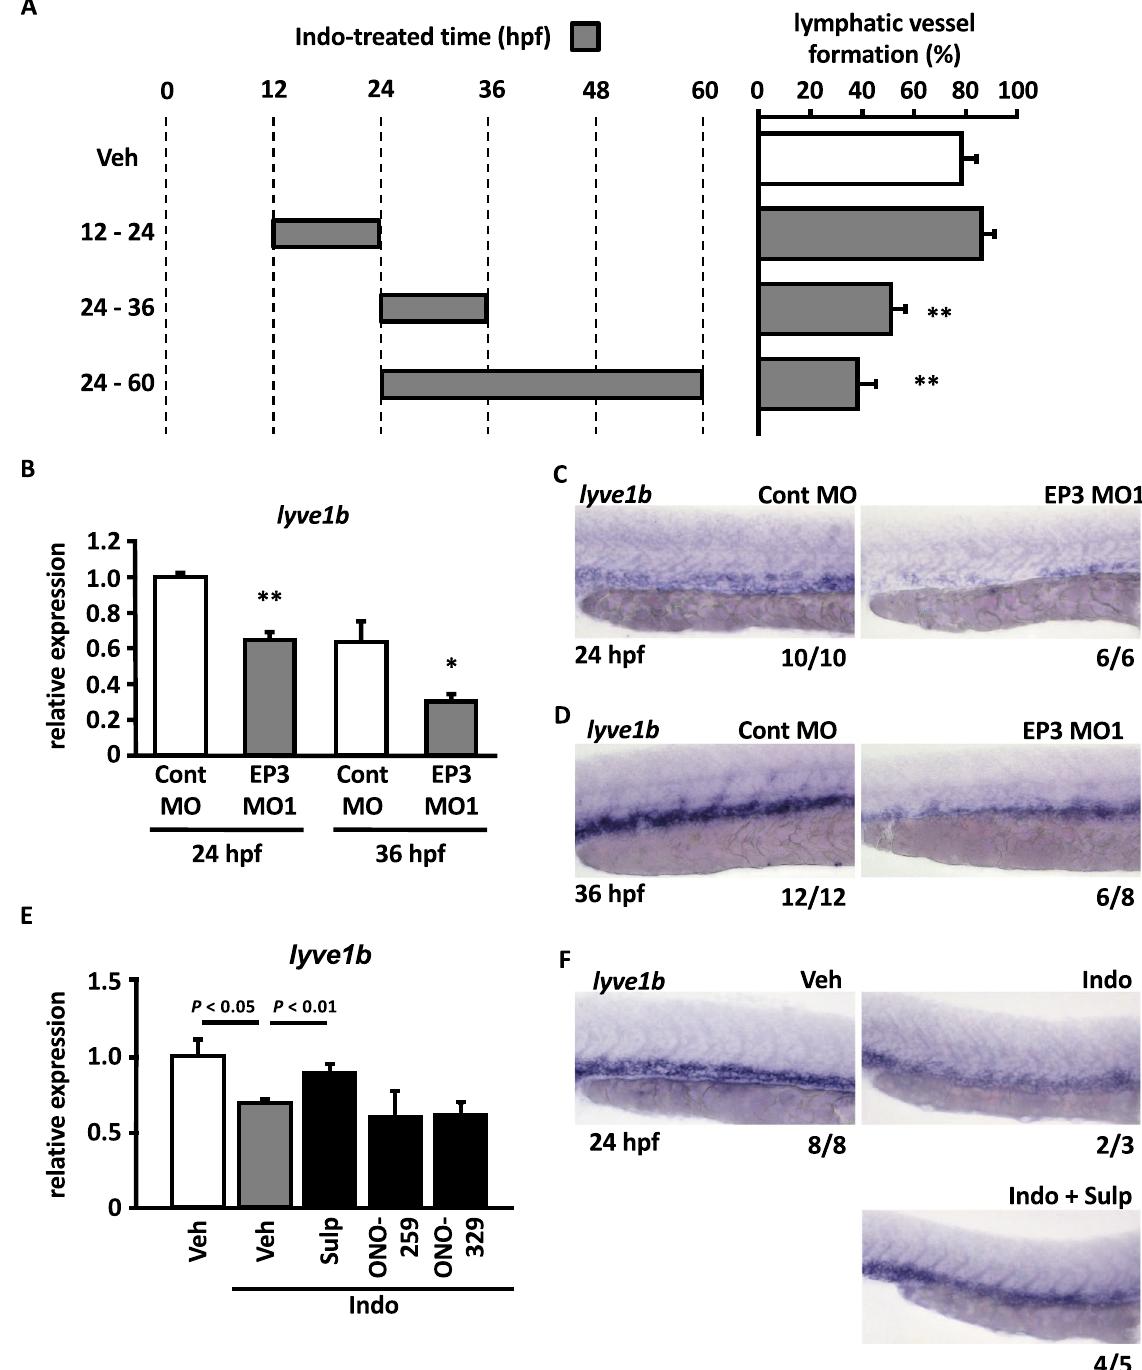
Figure 2. Role of the PGE 2 -EP3 pathway in the lymphatic specification from venous to lymphatic endothelial cells. ( A ) Tg(fli1a:egfp) embryos were treated with Veh or Indo (100 μ M) for the indicated times. The ratio of PL-positive segments at 60 hpf was quantified. Each value represents the mean ± SEM (N = 5). ** P < 0.01 vs Veh. ( B ) Relative expression levels of lyve1b were quantified by RT-qPCR in morphants at 24 and 36 hpf. Values are shown relative to the value obtained with Cont MO at 24 hpf. Each value represents the mean ± SEM (N = 3–4) * P < 0.05, ** P < 0.01 vs Cont MO at each corresponding time. (C,D) Expression of lyve1b was analyzed by WISH in morphants at 24 hpf ( C ) and 36 hpf ( D ). ( E , F ) Zebrafish embryos were treated with Veh or Indo (100 μ M) in the absence or presence of EP agonists (10 μ M) from 0 to 24 hpf. The expression level of lyve1b was quantified by RT-qPCR ( E ). The values are shown relative to the value obtained with Veh. Each value represents the mean ± SEM (N = 3–4). Expression of lyve1b was analyzed by WISH at 24 hpf ( F ). The number at the bottom right of each panel indicates the number of embryos demonstrating the phenotype shown in the panel over the total number of embryos analyzed in a representative